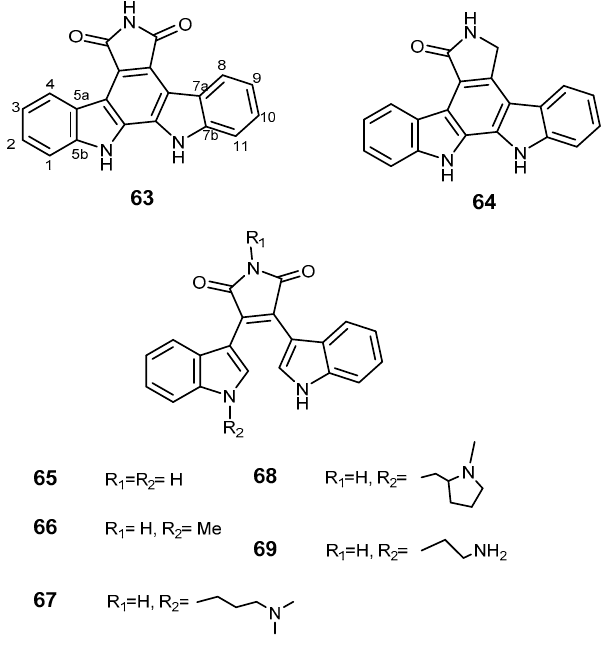
Figure 12. Structures of indolcarbazole derivatives 63 – 69 .